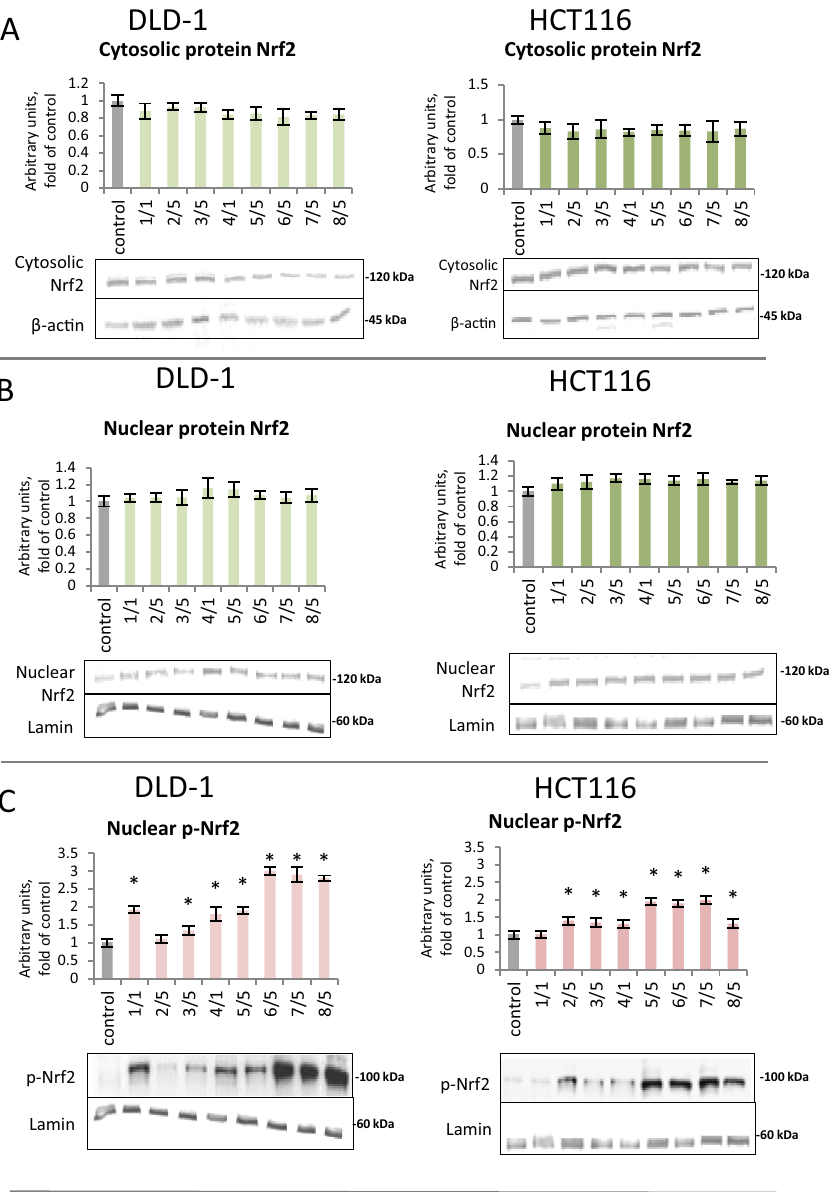
Figure 6. The effect of synthetic thioderivative chalcones compounds on Nrf2 activation in DLD-1 and HCT116 cells. ( A) The level of Nrf2 protein in the cytosolic fraction. ( B) The level of Nrf2 protein in the nuclear fraction. ( C) The level of p-Nrf2 protein in the nuclear fraction. ( D) The level of Keap1 protein in the cytosolic fraction. Representative Western immunoblots are presented under the graphs ( A–D ). ( E) The level of Nrf2 binding to DNA. The values (mean ± SEM) were calculated as a relative change in the transcript or protein level in comparison with control cells (where control expression equals 1). The values from three separate experiments run in triplicate are presented. Asterisk: mean values were significantly different from the control group (p ≤ 0.05). Original scans of blots are shown in Supplementary Fig.